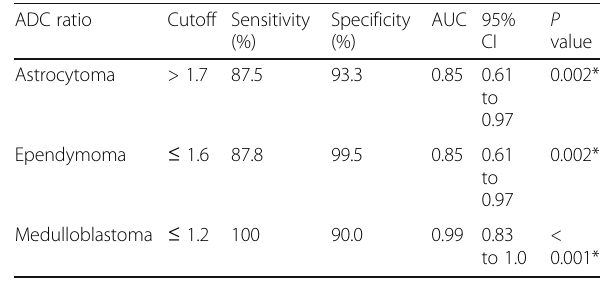
Table 5 ROC curve analysis for prediction of tumor type